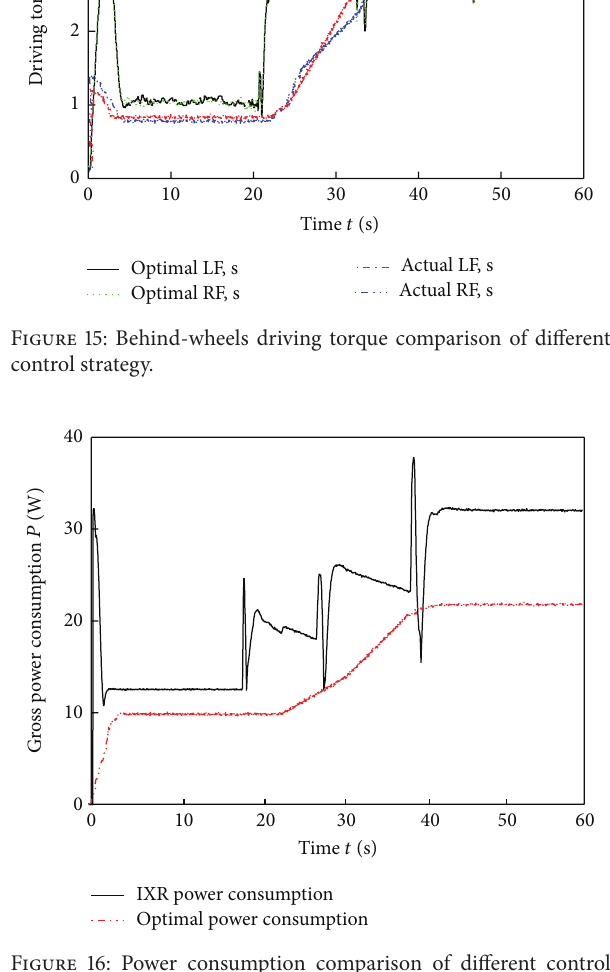
Figure 14: Middle-wheels driving torque comparison of different control strategy.